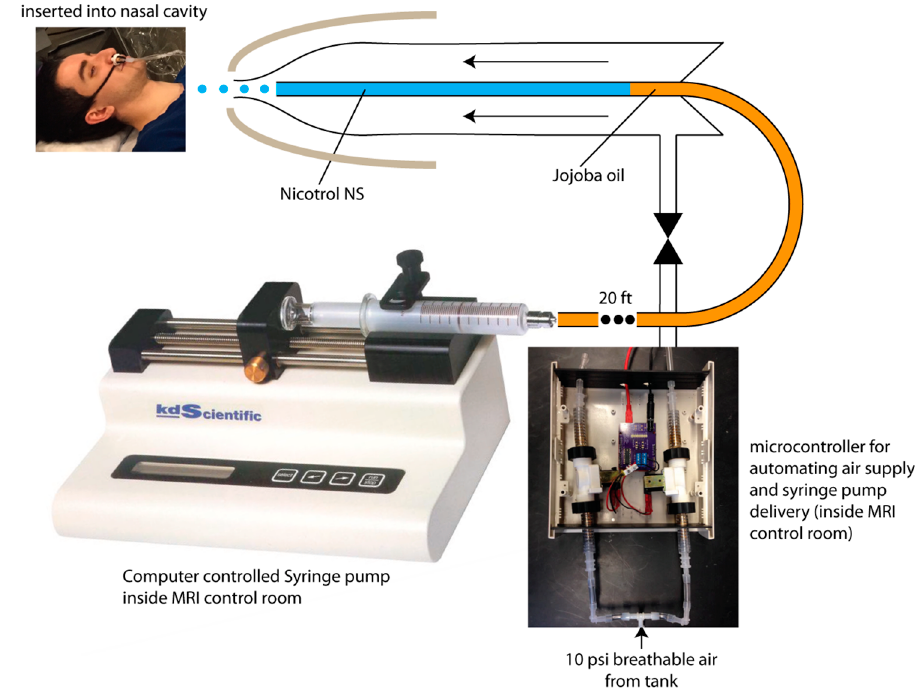
Figure 1. Schematic of the MRI ‐ compatible intranasal nicotine delivery apparatus.